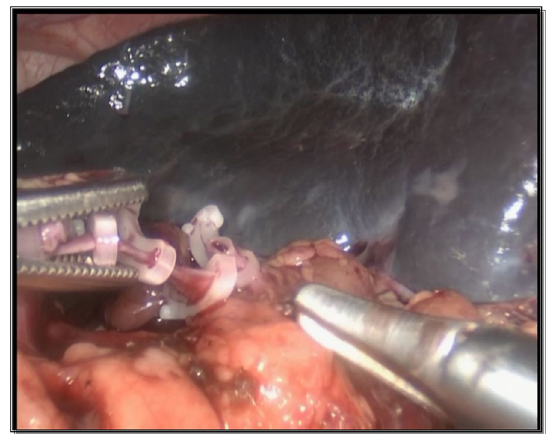
Fig. 3 Control of the artery with Hem-o-lock clips